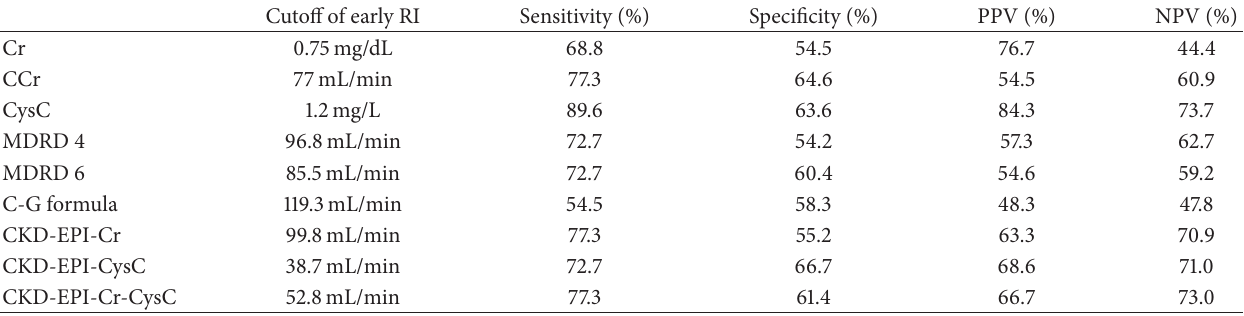
Table 6: Cutoffs of measures and estimates for detection of early renal impairment with their measures of diagnostic accuracy. Cutoff of early RI